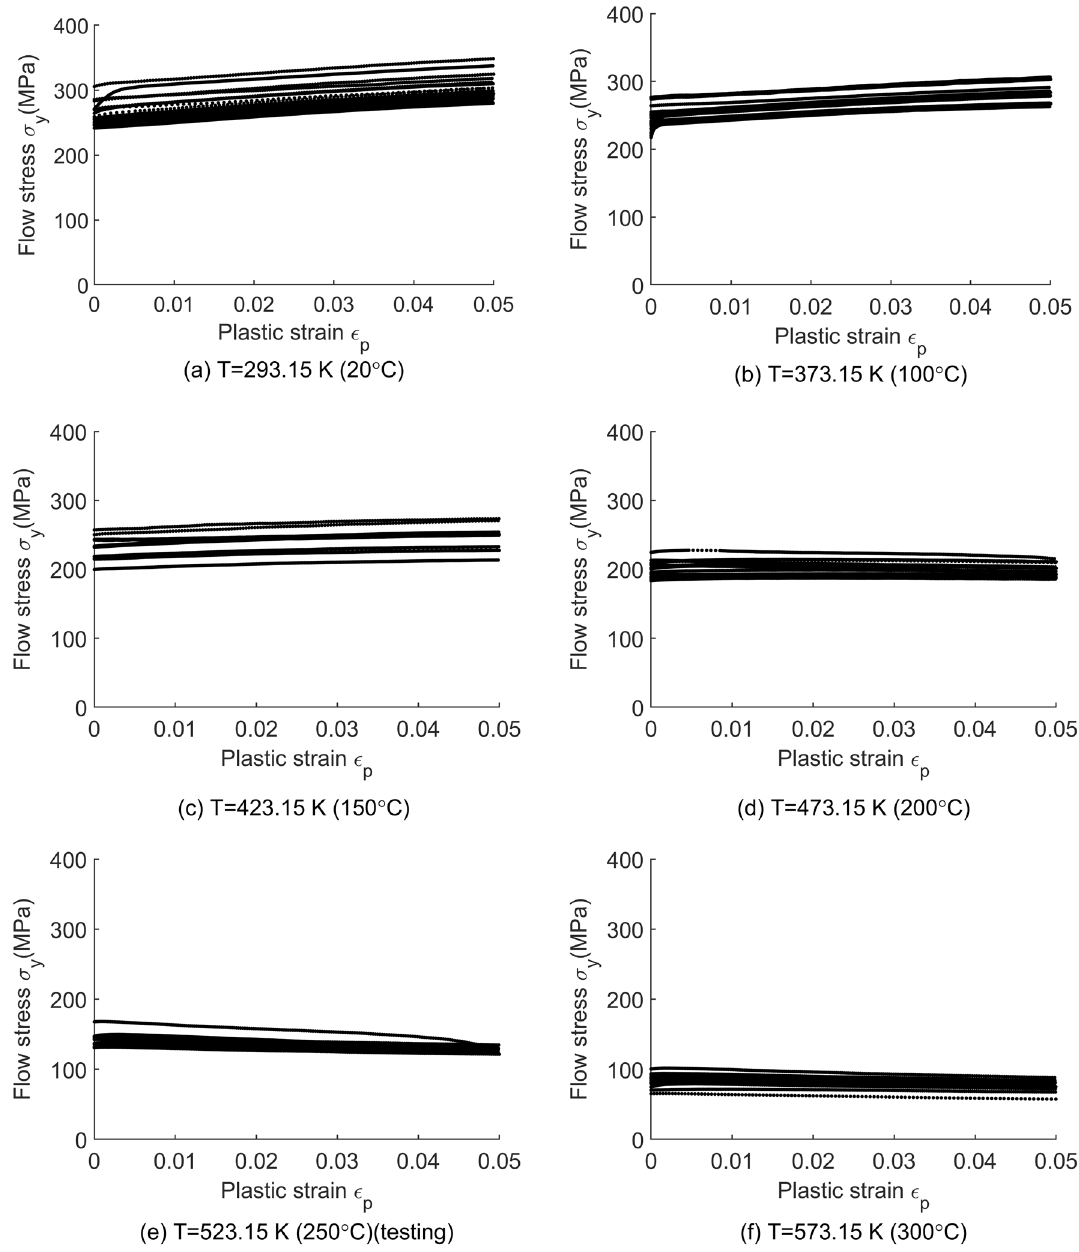
Figure 2. The experimental flow stress-plastic strain data of Al6061 aluminum alloys at the temperature of ( a ) 20 °C, ( b ) 100 °C, ( c ) 150 °C, ( d ) 200 °C, ( e ) 250 °C and ( f ) 300°C 28 .